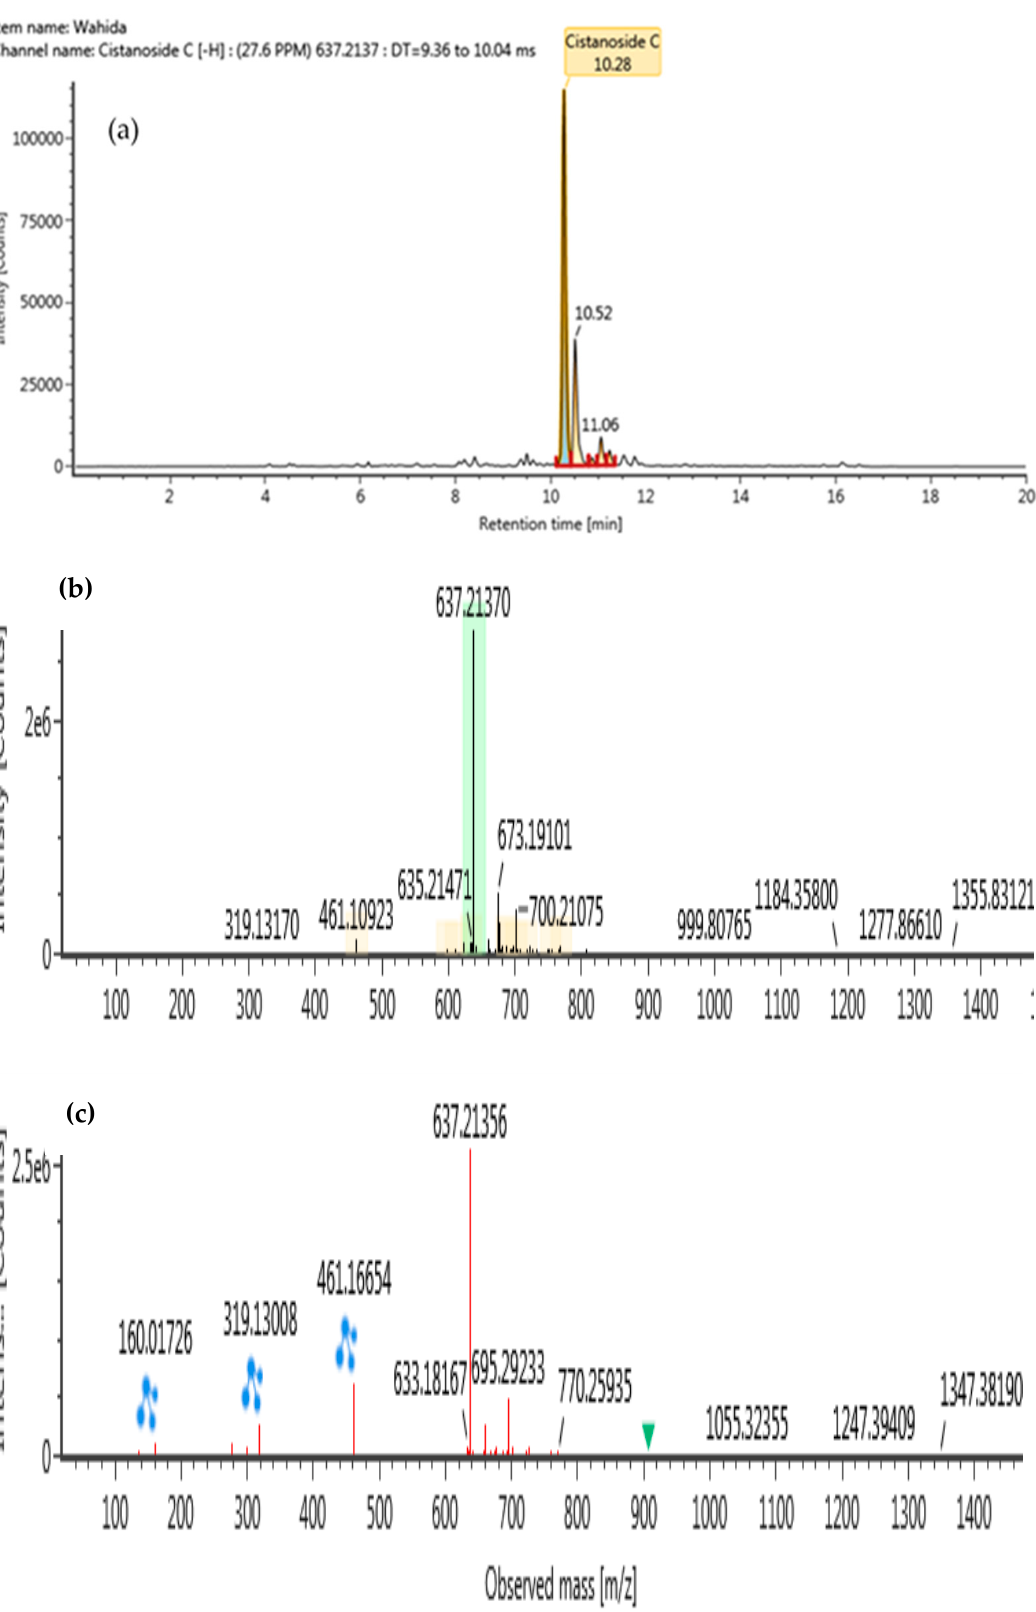
Figure 7. UHPLC-QTOF/MS chromatograms of cistanoside C from Barleria lupulina Lindl. leaf extract (BLLE): ( a ) chromatogram mass spectrum; ( b ) low energy of mass spectrum; ( c ) high energy of mass spectrum.